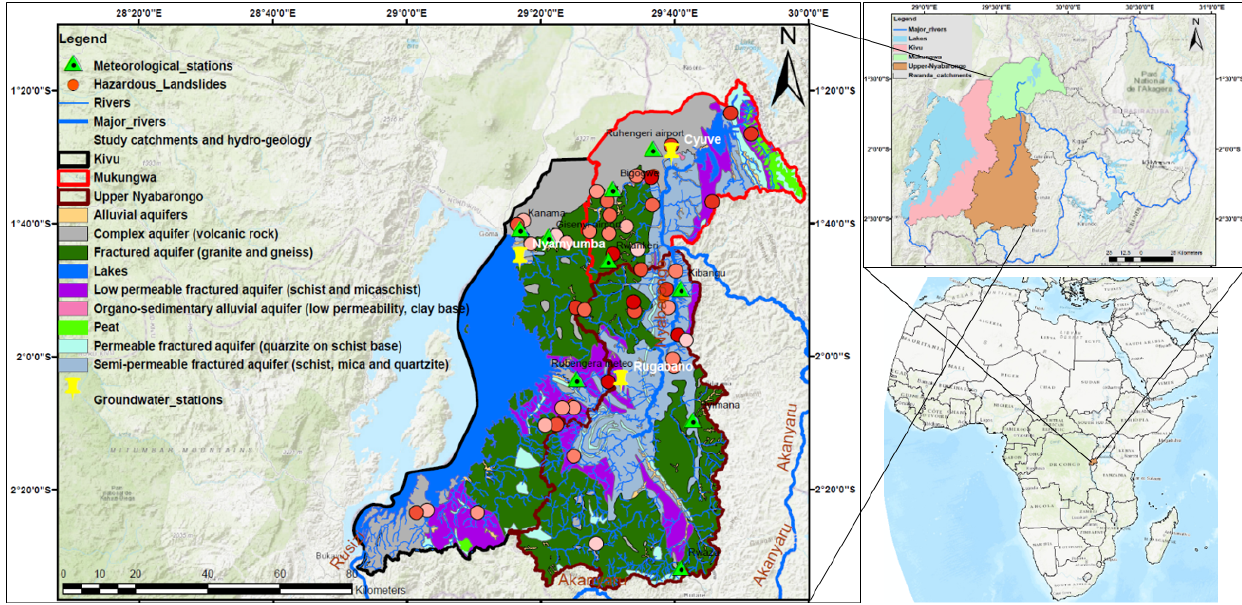
Figure 1. Location of the study catchments: Kivu, upper Nyabarongo, and Mukungwa in Rwanda and Africa; hydrogeology of the study catchments; spatial and temporal distribution of landslides with light to dark red dots indicating old to new landslides recorded from 2006– 2018 (Uwihirwe et al., 2020); and groundwater stations in yellow symbols and meteorological stations in light green symbols.